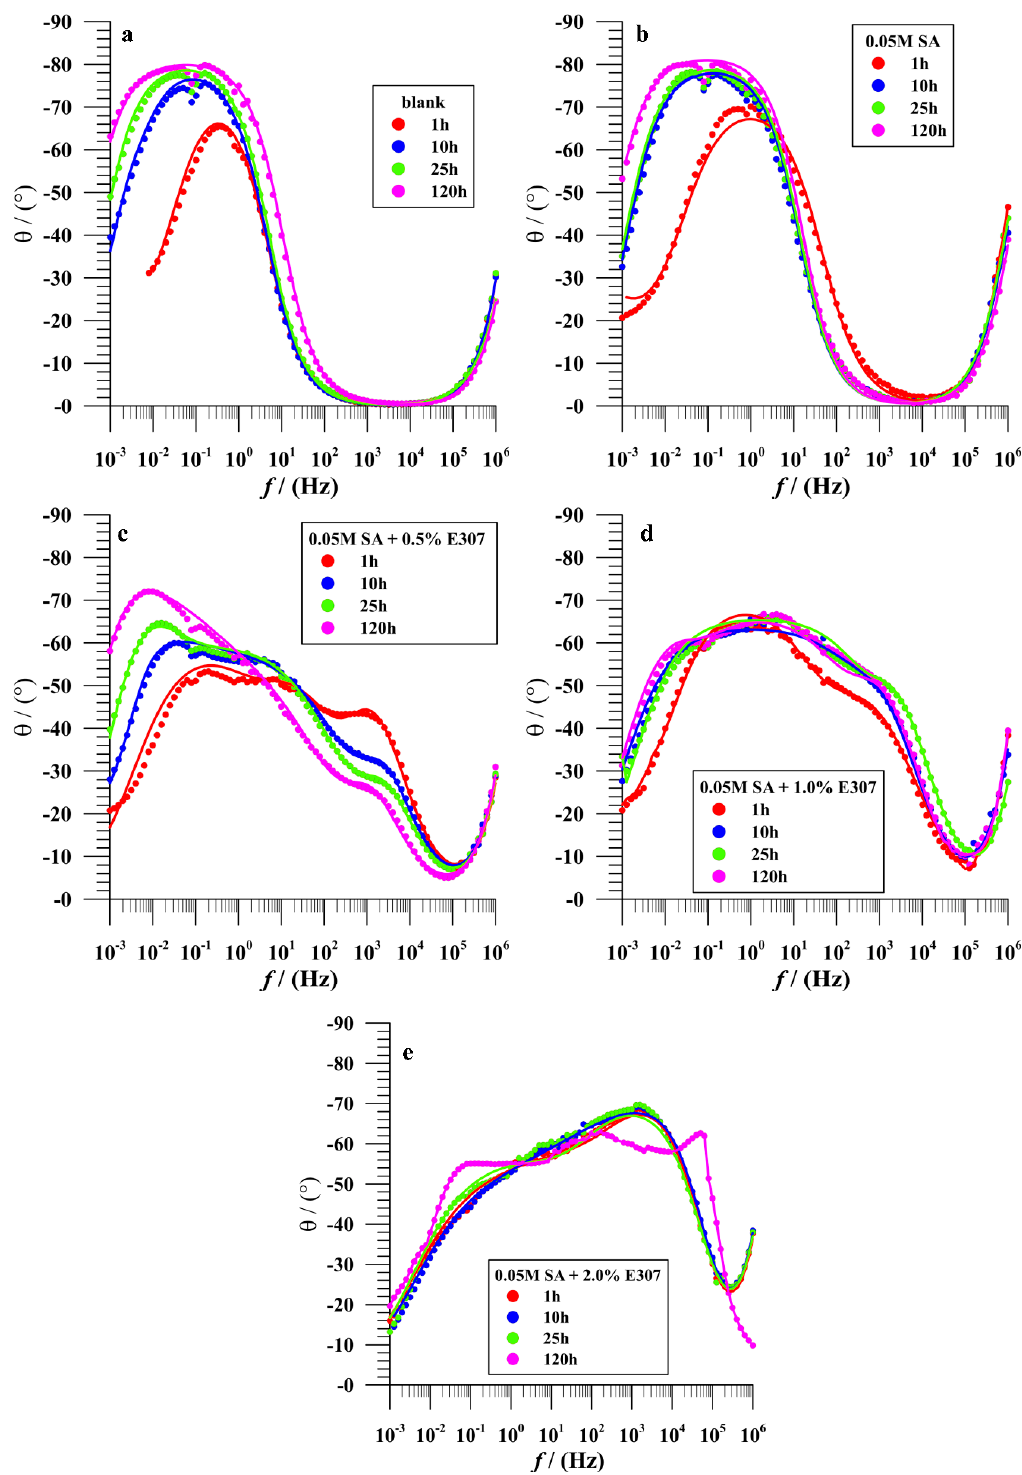
Figure 7. Bode-phase angle plots of SS AISI 410S samples for bare and modified surfaces measured after 1, 10, 25, and after 120 h of immersion at their open-circuit potential in a simulated solution of acid rain with pH = 3 at 25 °C: ( a ) Blank, ( b ) SA, ( c ) (SA + 0.5% E307), ( d ) (SA + 1.0% E307) and ( e ) (SA + 2.0% E307) (measured data-dotted symbols and fitted data-solid lines).